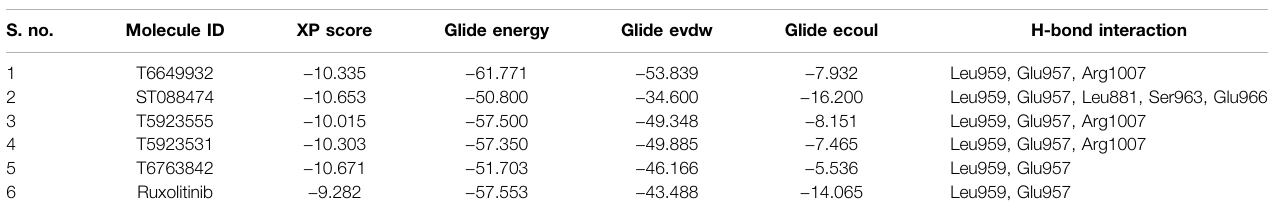
TABLE 7 | Molecular docking results of the selected JAK1 lead compounds and the drug. S.